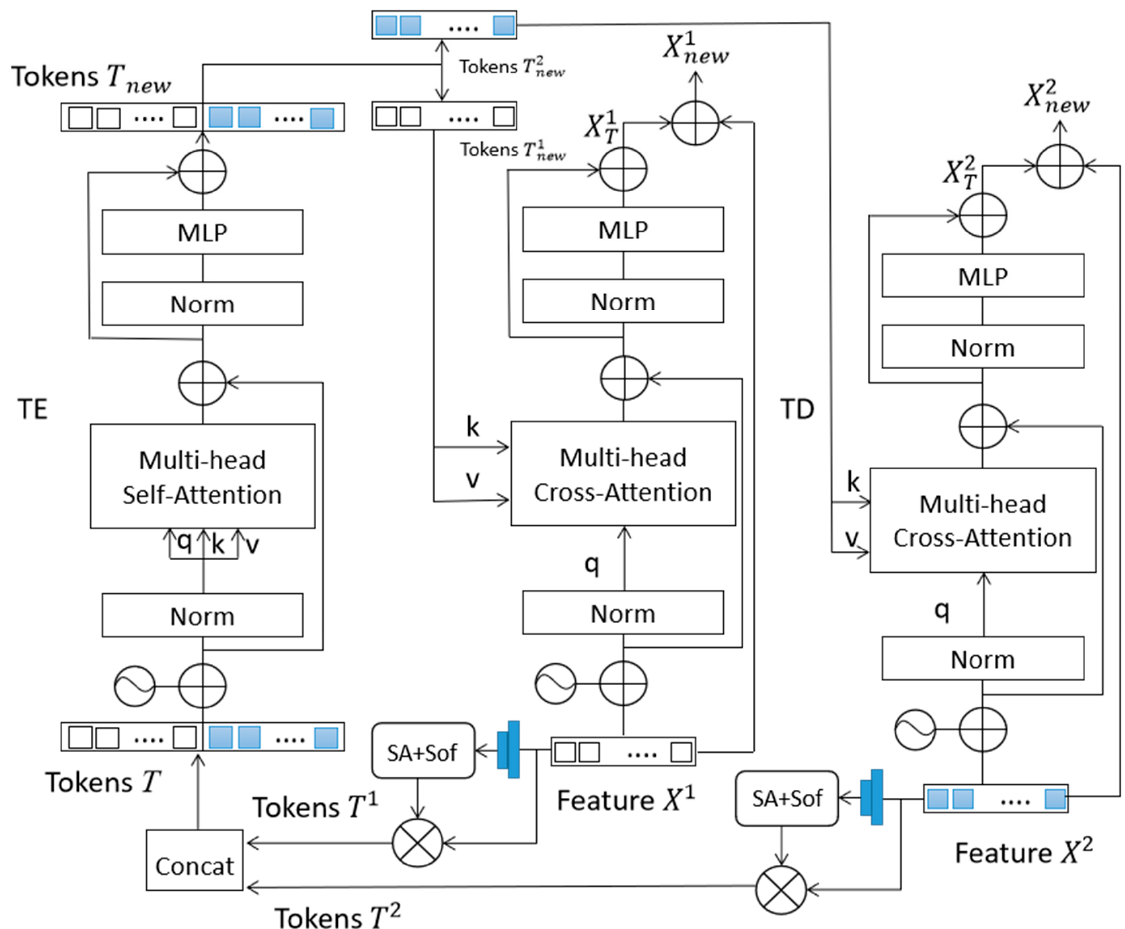
Figure 3. Bitemporal image transformer module and feature fusion.